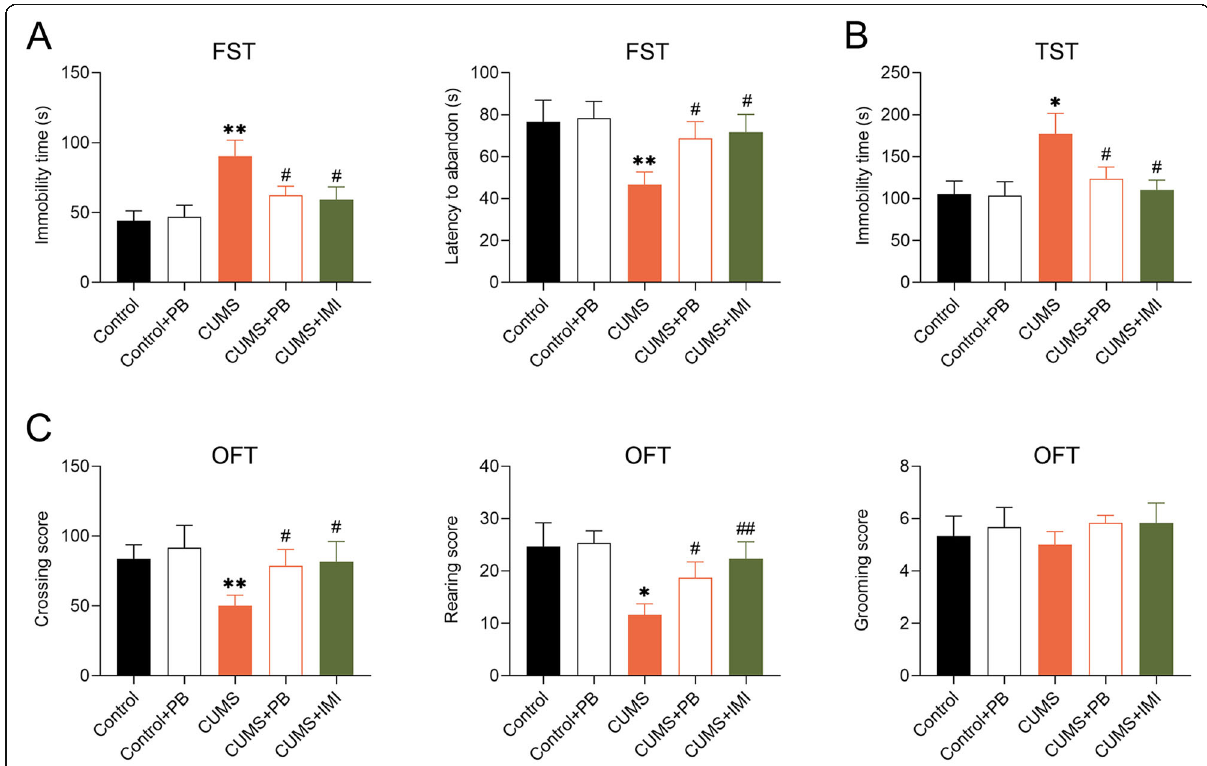
Fig. 2 PB alleviated depressive-like behaviors of CUMS mice a PB decreased the immobility time but increased latency to abandon of CUMS mice in the forced swimming test (FST). b PB reduced the immobility time of CUMS mice in the tail suspension test (TST). c PB promoted crossing score and rearing score of CUMS mice in the open field test (OFT), with no change in grooming score. Eight mice per group. ** p < 0.01 vs. Control. # p < 0.05, ## p < 0.01 vs.